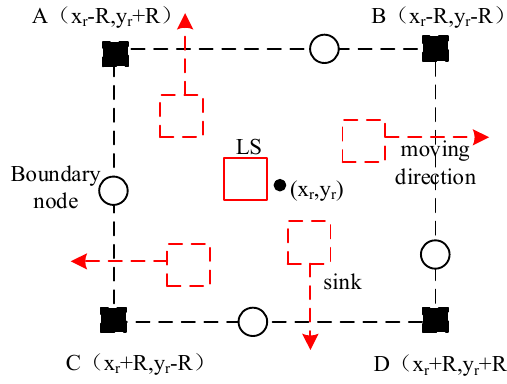
Figure 6. The system model of REEMS [58].